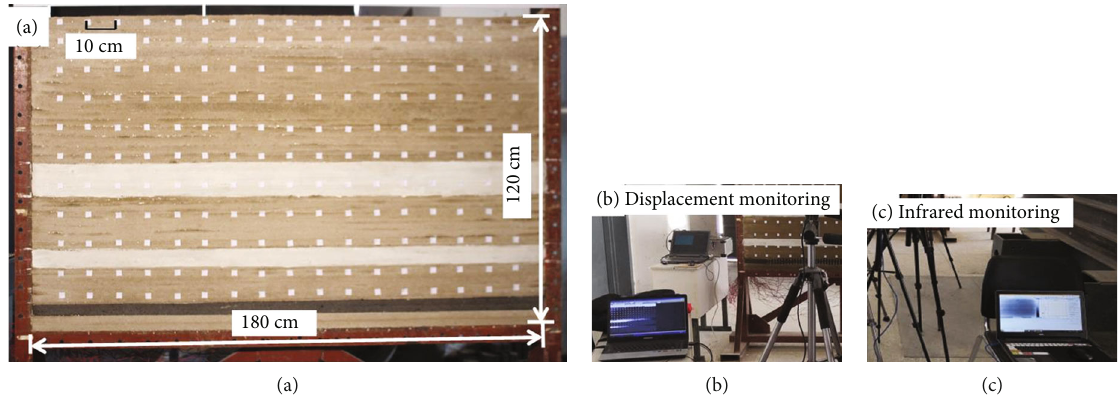
Figure 5: Physical model and measuring equipment. Table 2: Material ratio of physical similarity